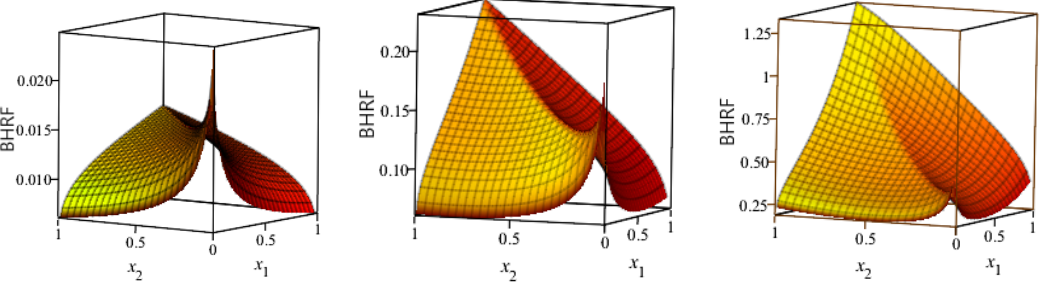
Figure 3. The surface plots of the bivariate hazard rate function (BHRF) for γ 1 = γ 2 = γ 3 = 0.3 and a = 0.1, 0.3 and 0.5, respectively.